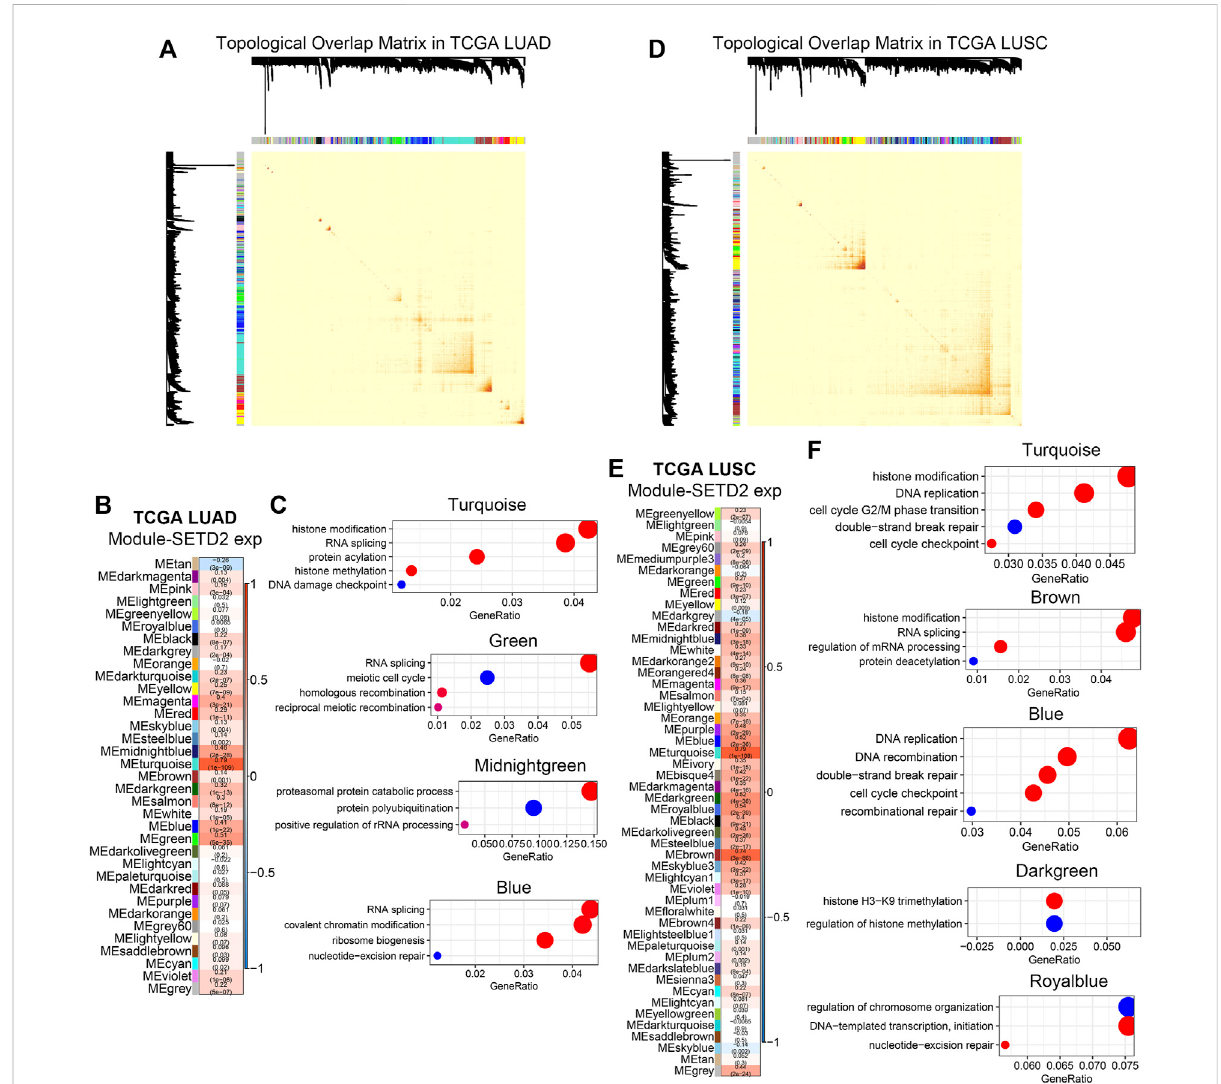
FIGURE 4 SETD2 regulated transcriptional patterns in bulk RNA-seq. (A) Visualization of topological overlap matrix in TCGA LUAD. (B) WGCNA revealed the gene clusters related to SETD2 in TCGA LUAD. (C) GO enrichment analysis of SETD2-related clusters in TCGA LUAD. (D) Visualization of topological overlap matrix in TCGA LUSC. (E) WGCNA revealed the gene clusters related to SETD2 in TCGA LUSC. (F) GO enrichment analysis of SETD2-related clusters in TCGA